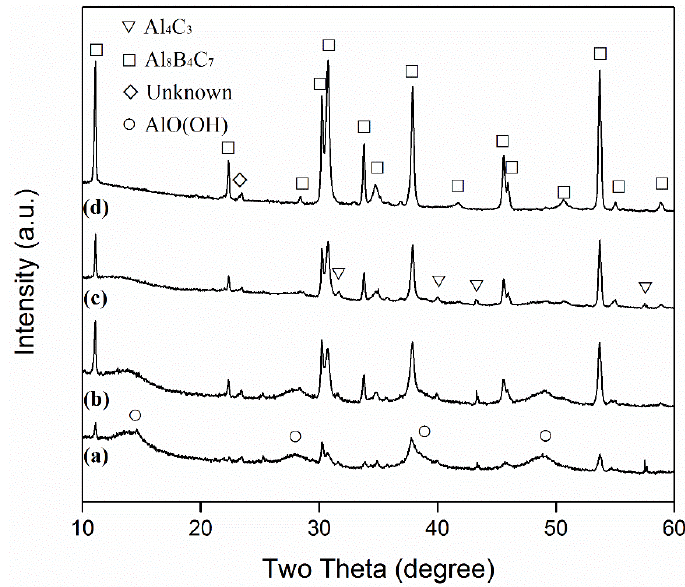
Figure 2. XRD patterns of samples resulting from 6 h of firing at: ( a ) 1100, ( b ) 1150, ( c ) 1200, and ( d ) 1250 °C, respectively (after water washing).